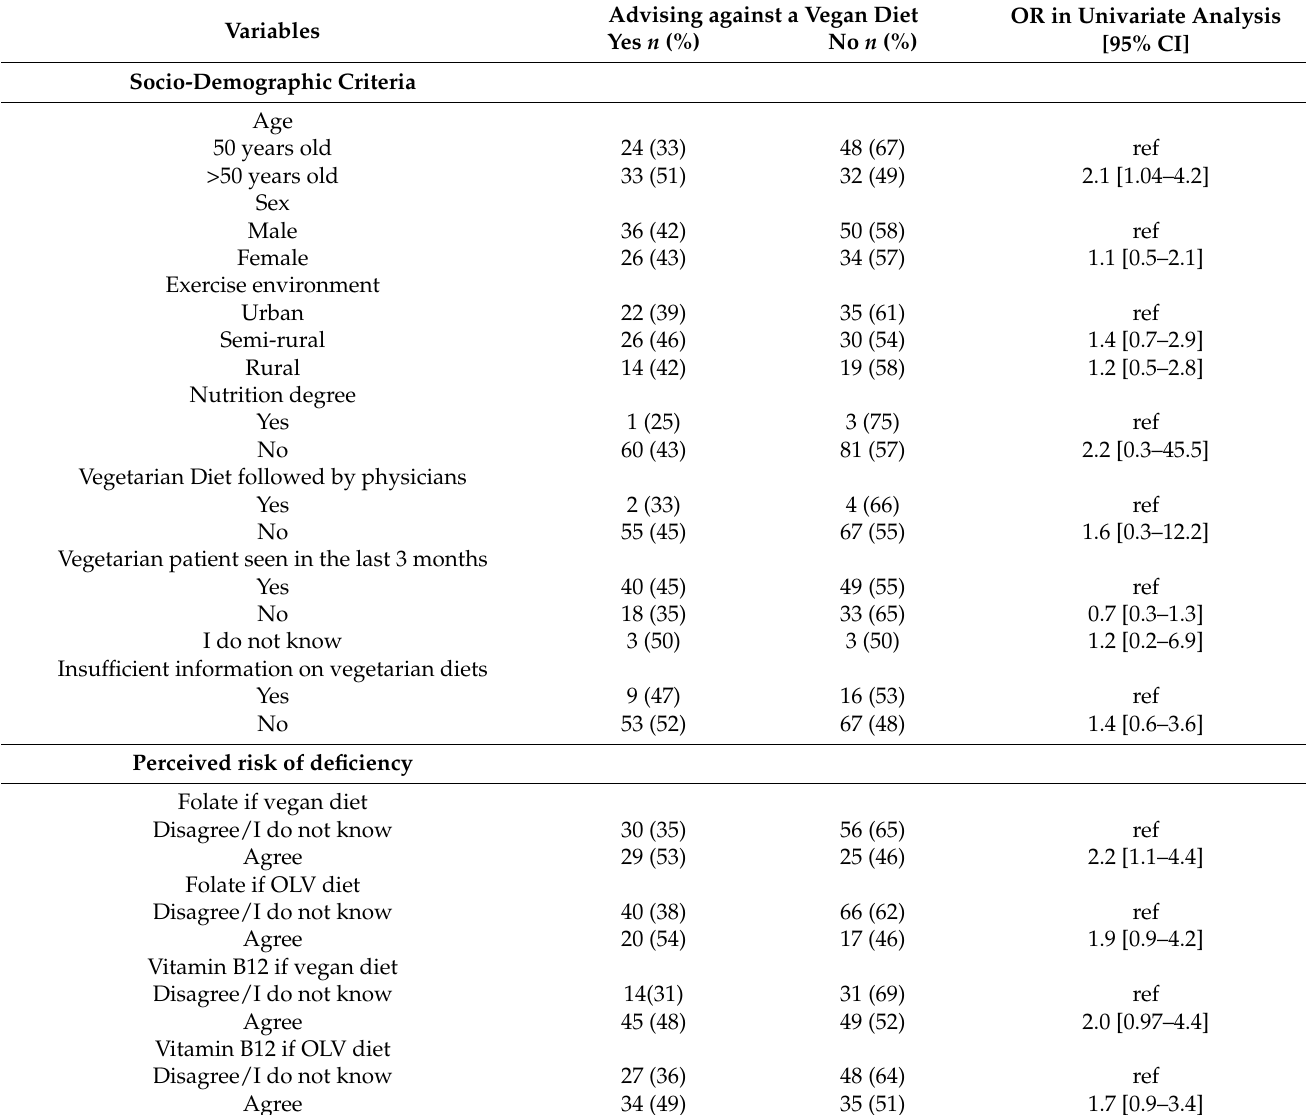
Table 4. Determinants associated with advising against a vegan diet in the GP population N = 149.